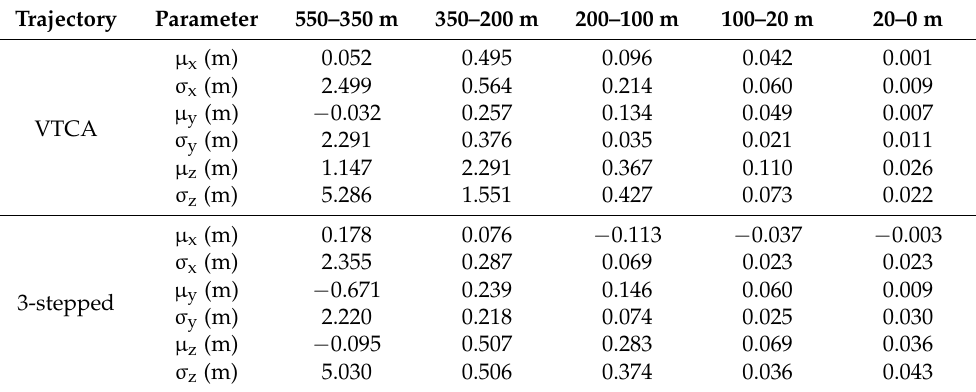
Table 3. Mean ( µ ) and standard deviation ( σ ) over 50 simulations of the EKF position estimates errors computed along different sections of the trajectories in nominal visibility conditions.